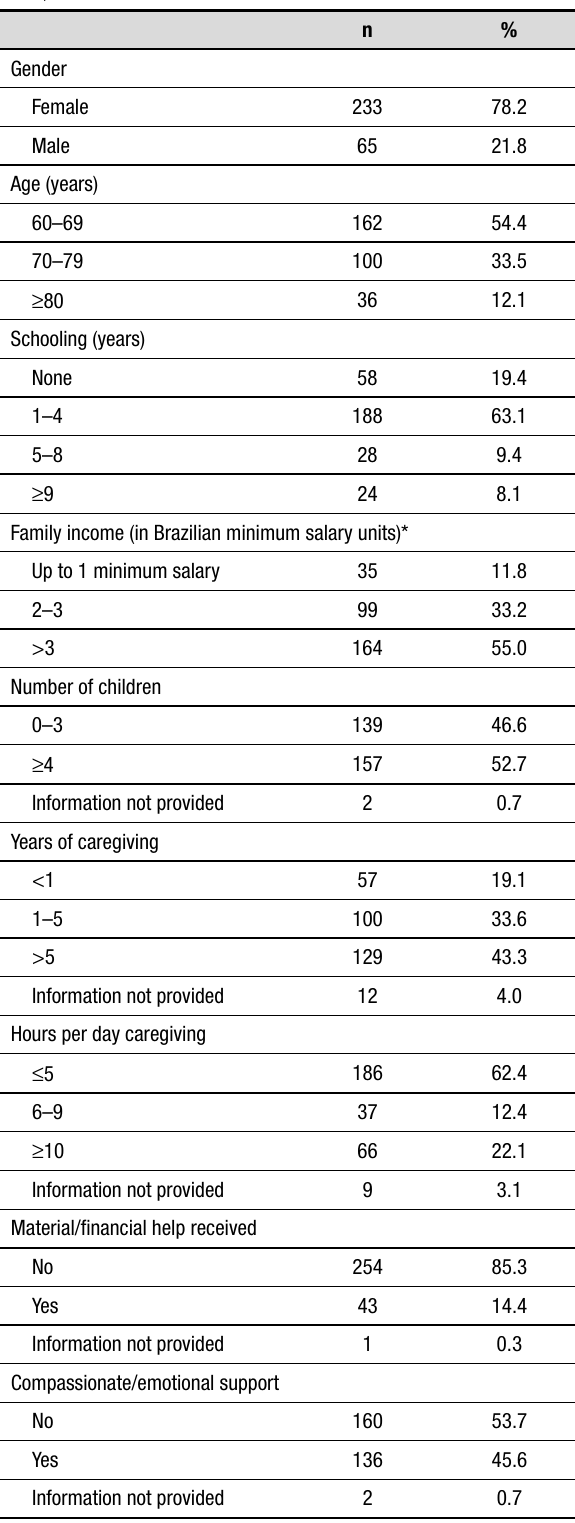
Table 1. Sociodemographic and care information (n=298), São Carlos, SP, Brazil,